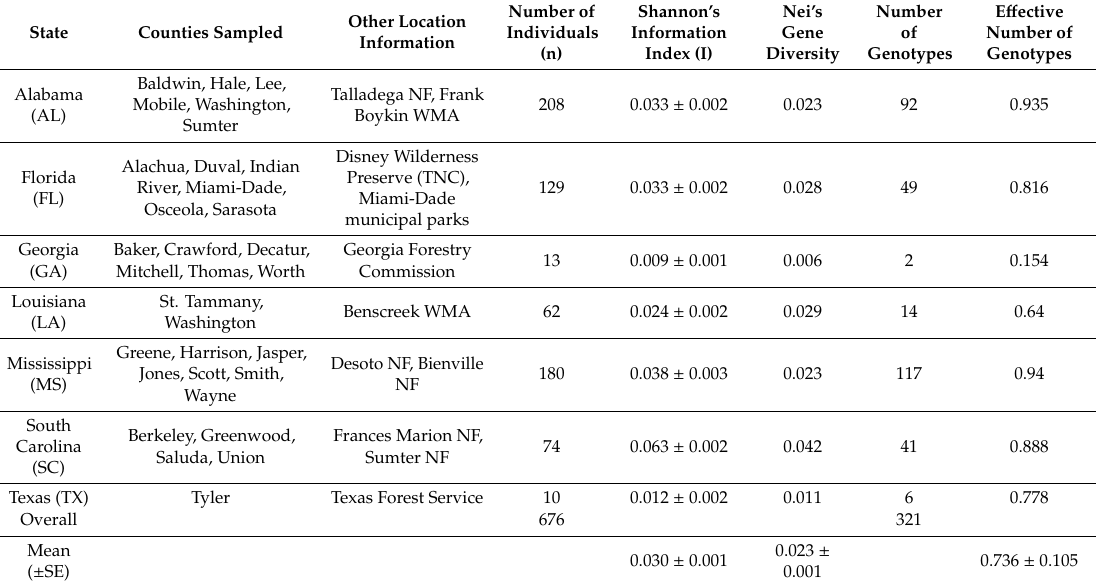
Table 1. State-level sampling and location information with genetic and genotypic diversity